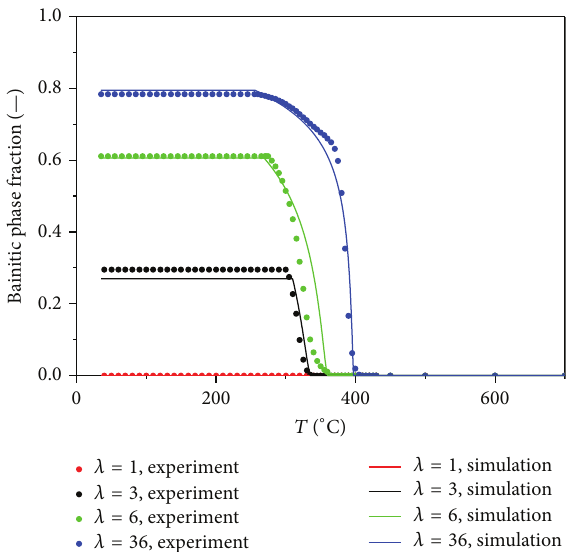
Figure 1: Comparison of calculated and experimental continuous phase diagram of X36CrMoV5-1 hot-work tool steel.